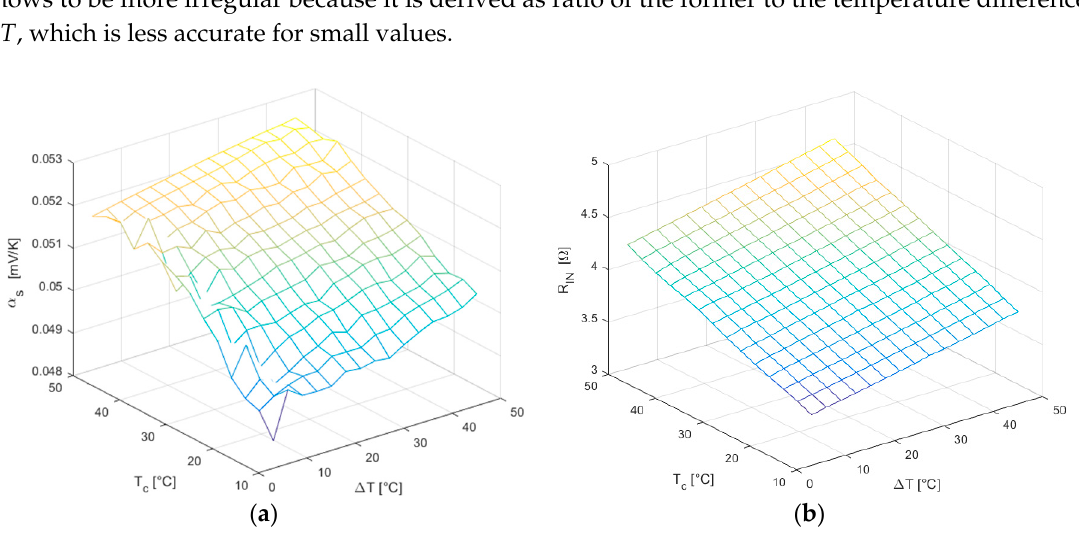
Figure 14. ( a ) Seebeck coefficient α S ; ( b ) Internal electrical resistance R IN